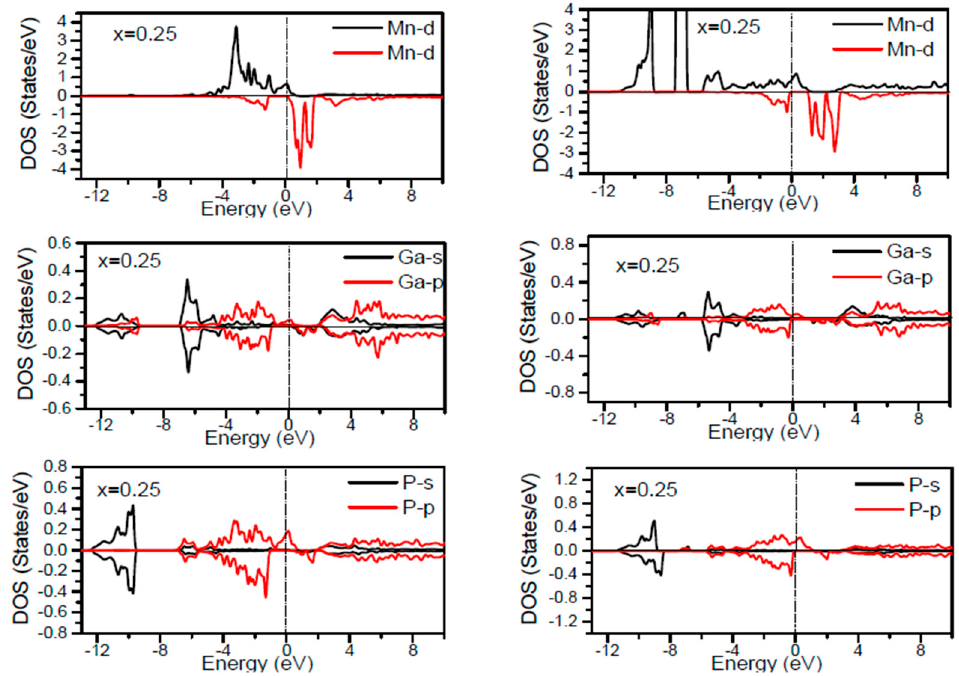
Figure 4. Computed partial DOS of spin polarized contributions from Ga-s,p, As-s,p, and Mn-d states in the Ga 1 − x MnP ( x = 0.25) alloys for spin up and spin down. The left panel indicates the GGA calculations and right panel denotes the GGA + U calculations. The vertical dash line denotes the Fermi level.